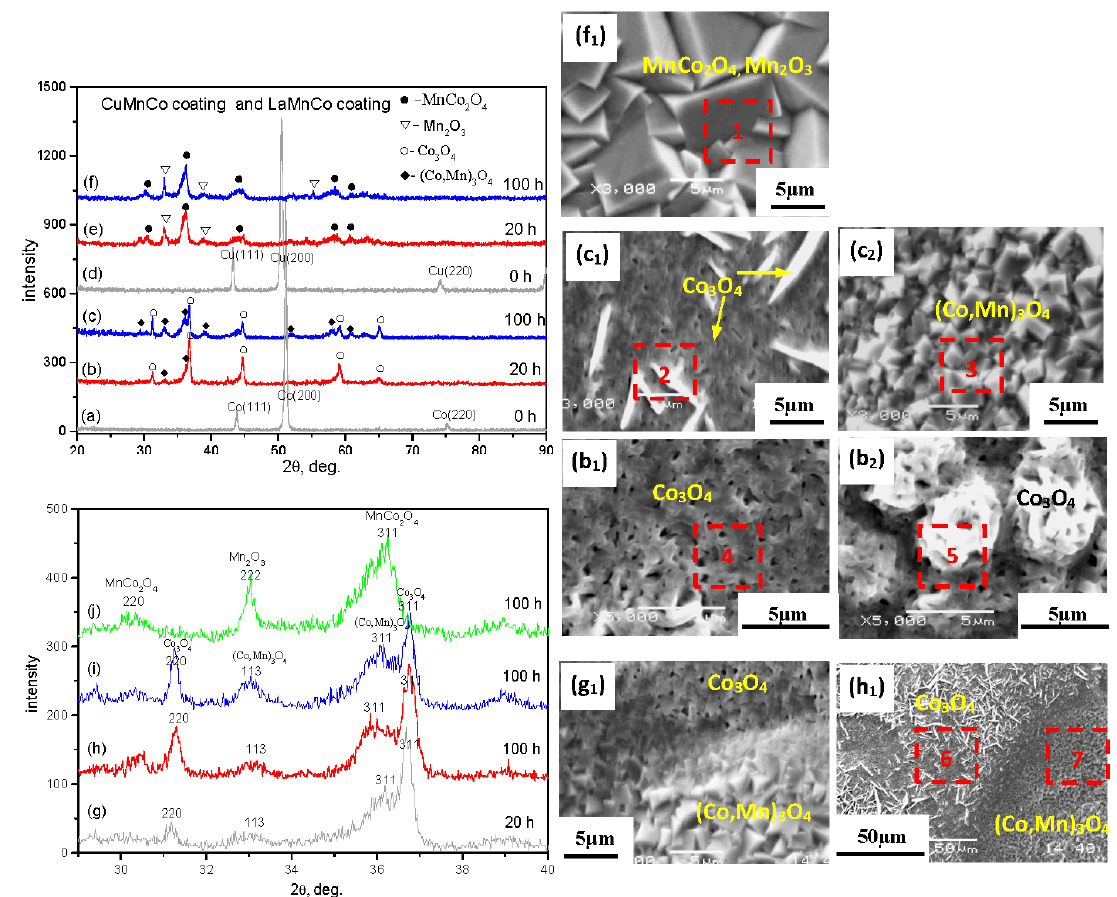
Figure 2. X-ray diffraction and surface morphology of coatings deposited by HEMAA oxidized at 750 °C in air. ( a – c ) Co-38Mn-2La coating oxidized for 0 h, 20 h and 100 h; ( d – f ) Co-33Mn-17Cu coating oxidized for 0 h, 20 h and 100 h; ( g , h ) Co-40Mn coating oxidized for 20 h and 100 h; ( i ) Co-38Mn-2La coating oxidized for 100 h; ( j ) Co-33Mn-17Cu coating oxidized for 100 h; ( f 1 ) surface morphology of Co-33Mn-17Cu coating oxidized for 100 h; ( c 1 , c 2 ) and ( b 1 , b 2 ) surface morphology of Co-38Mn-2La coating oxidized for 100 h and 20 h; ( g 1 ) and ( h 1 ) surface morphology of Co-40Mn coating oxidized for 20 h and 100 h. Table 1. Composition analysis by energy dispersive X-ray spectroscopy (EDS) of local region in Figure 2. Element, at.%